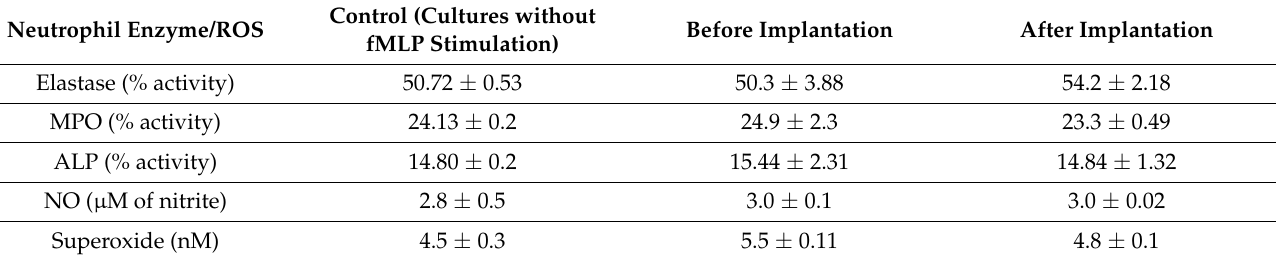
Table 2. Activity of ovine neutrophils isolated before and after Ti implant insertion assessed on the basis of enzyme release and free radical generation. Control (Cultures without Before Implantation After Implantation Neutrophil Enzyme/ROS fMLP Stimulation) Elastase (% activity) 50.72 ± 0.53 50.3 ± 3.88 MPO (% activity) 24.13 ± 0.2 ALP (%